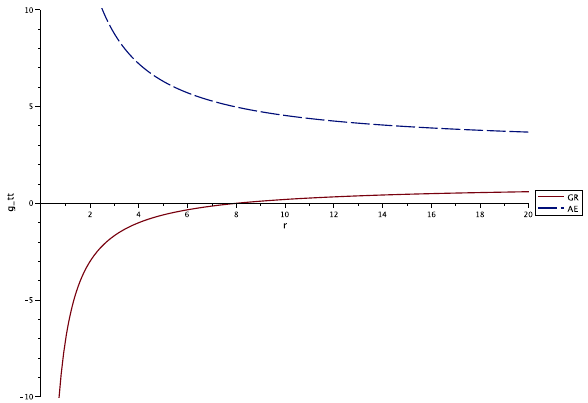
Fig. 2 Plot of the metric component g tt , for EA parameters c 14 = 16 / 9, α = − 1 and an arbitrary Schwarzschild mass M = 4. The continuousredlinerepresentstheGRSchwarzschildmetric.Thedashed blue line represents the EA solution. Calculating the limit r → +∞ we √ obtain g tt = e 2 A → 2 2, as we can see in this figure